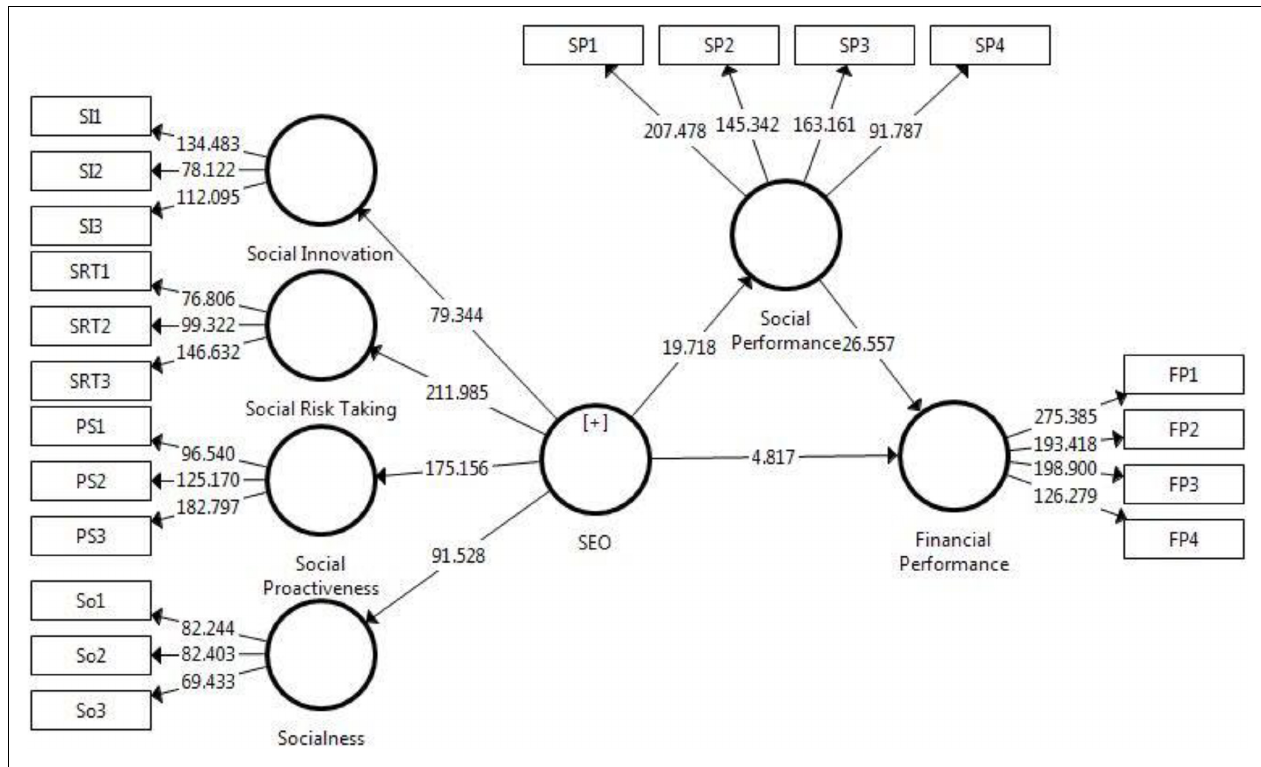
FIGURE 2 | Hypothesis